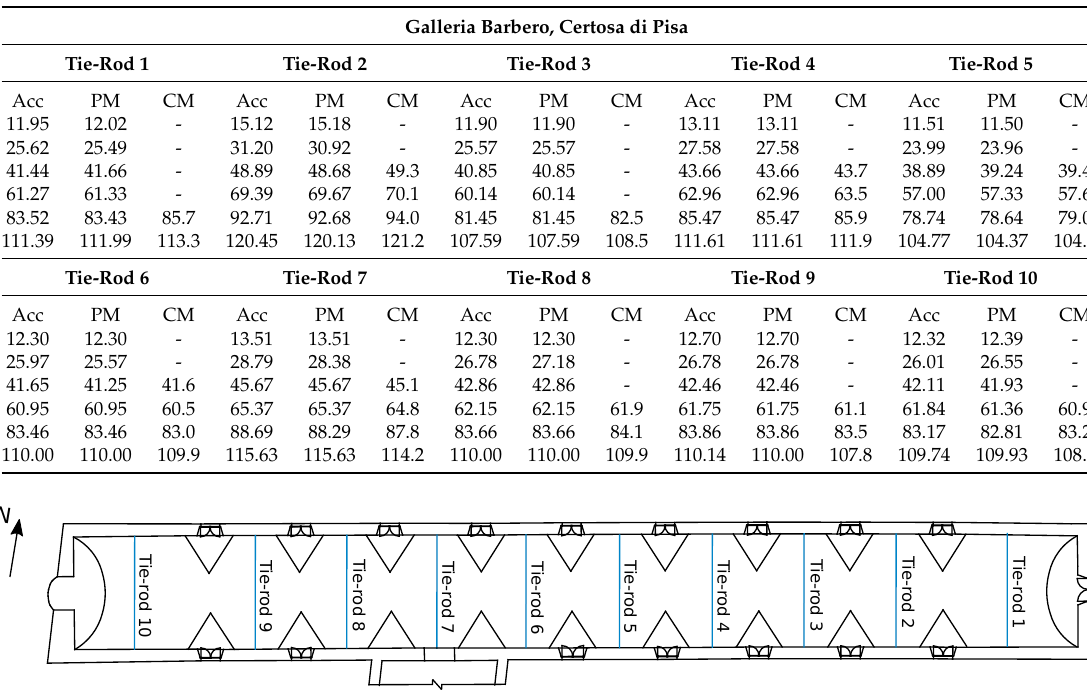
Table 1. Results of testing in the Certosa di Pisa: lowest natural frequencies of the measured ten tie-rods. Values obtained with accelerometer (Acc), professional microphone (PM) and cellphone microphone (CM).